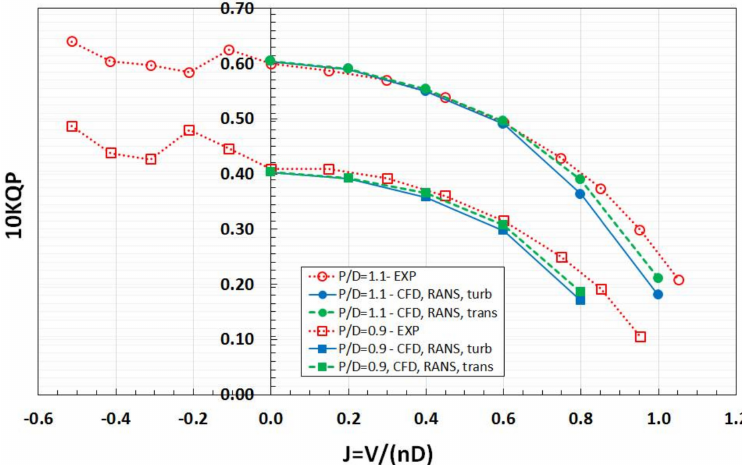
Figure 8. Measured (red) and computed (blue—fully turbulent model, green—transition model) propeller torque, KQP, at the two propeller pitch settings, P/D, and different loading